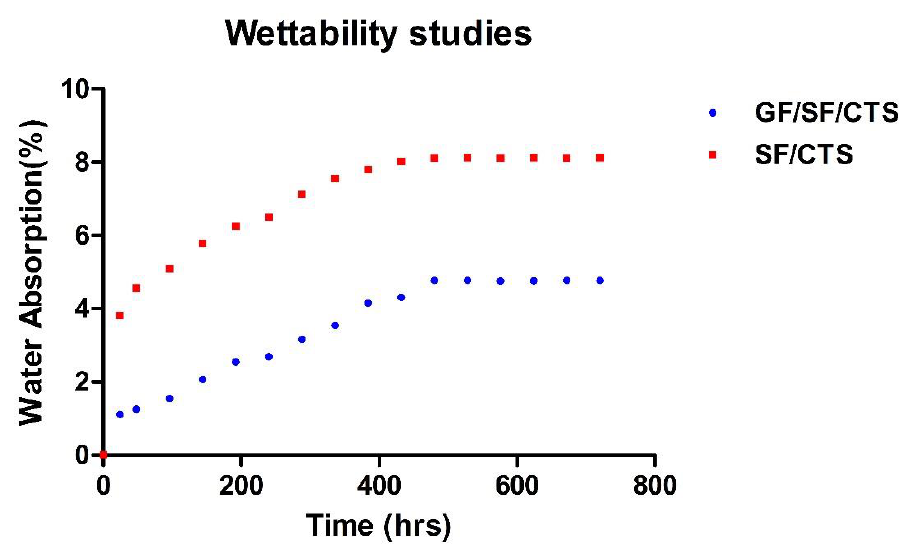
Figure 13. Water absorption of GF/SF/CTS and SF/CTS composites.